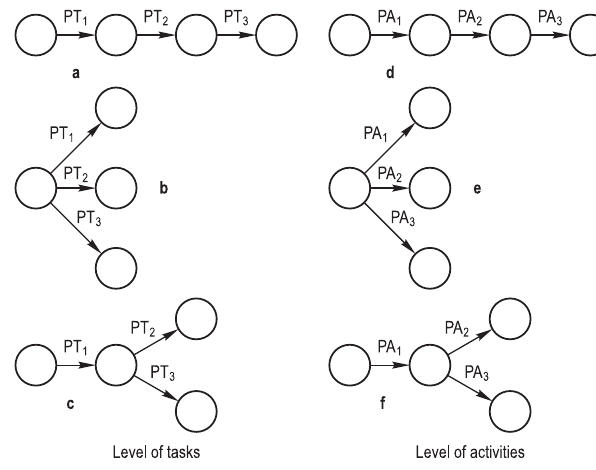
Fig 2. Achieving the goals by applying different combinations of elements of an action